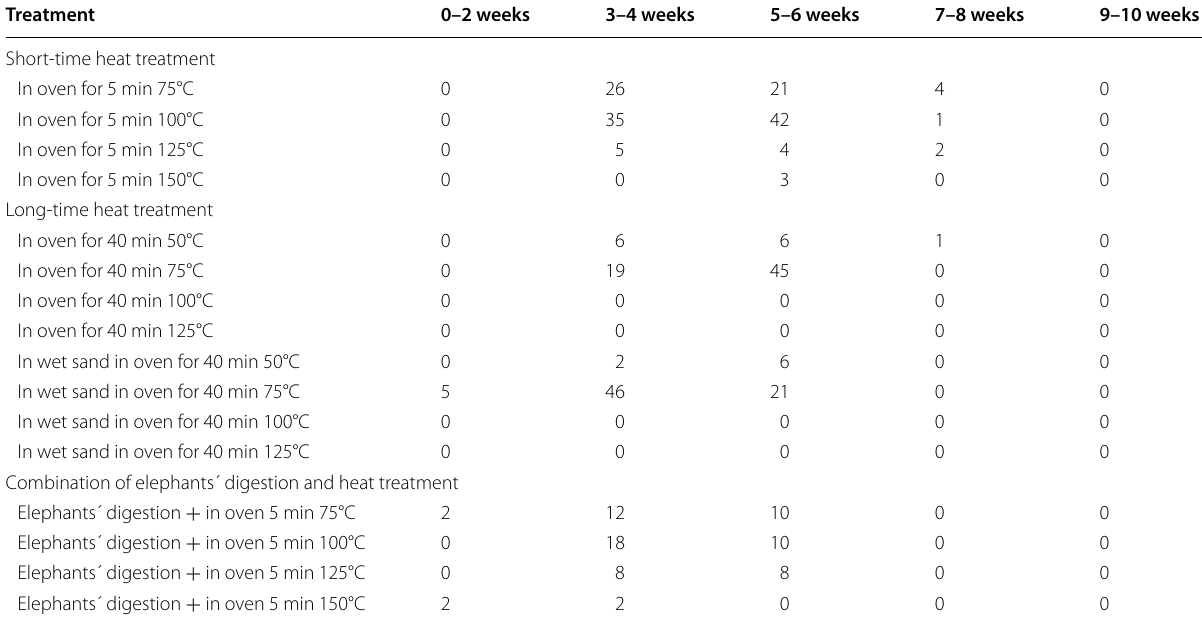
Numbers marked with a are the average of the germination tests (2017, 2018, 2019) the remaining numbers are obtained in the test sets in 2018 or